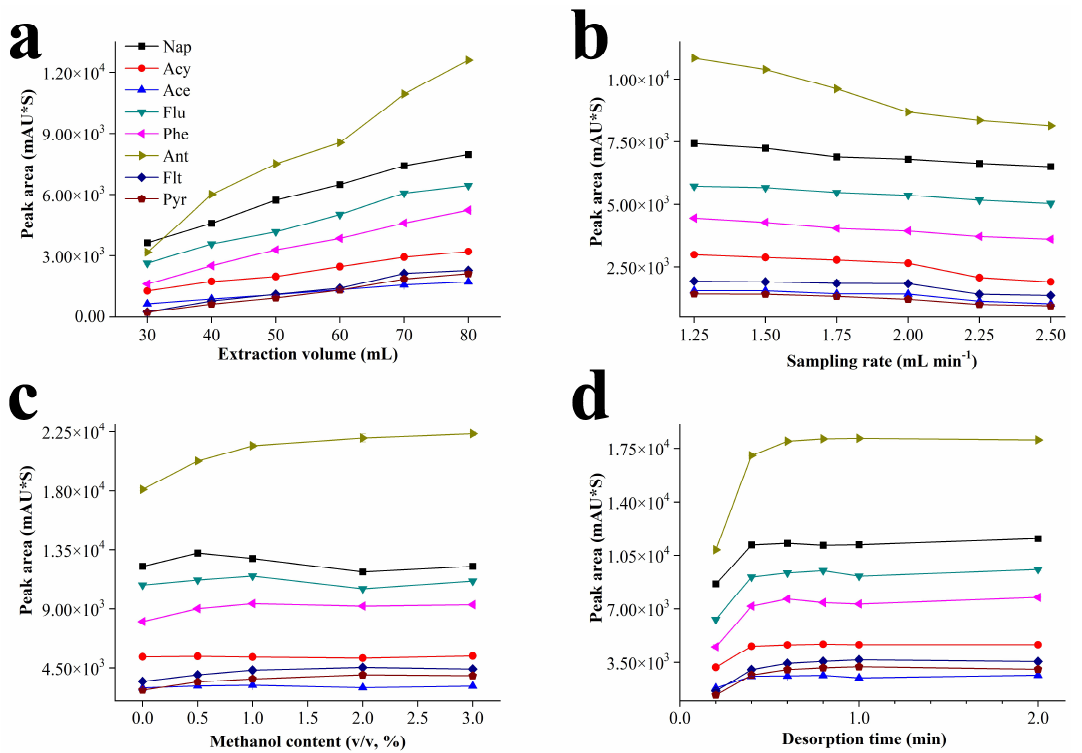
Figure 3. The effect results of ( a ) extraction volume, ( b ) sampling rate, ( c ) methanol content and ( d ) desorption time.